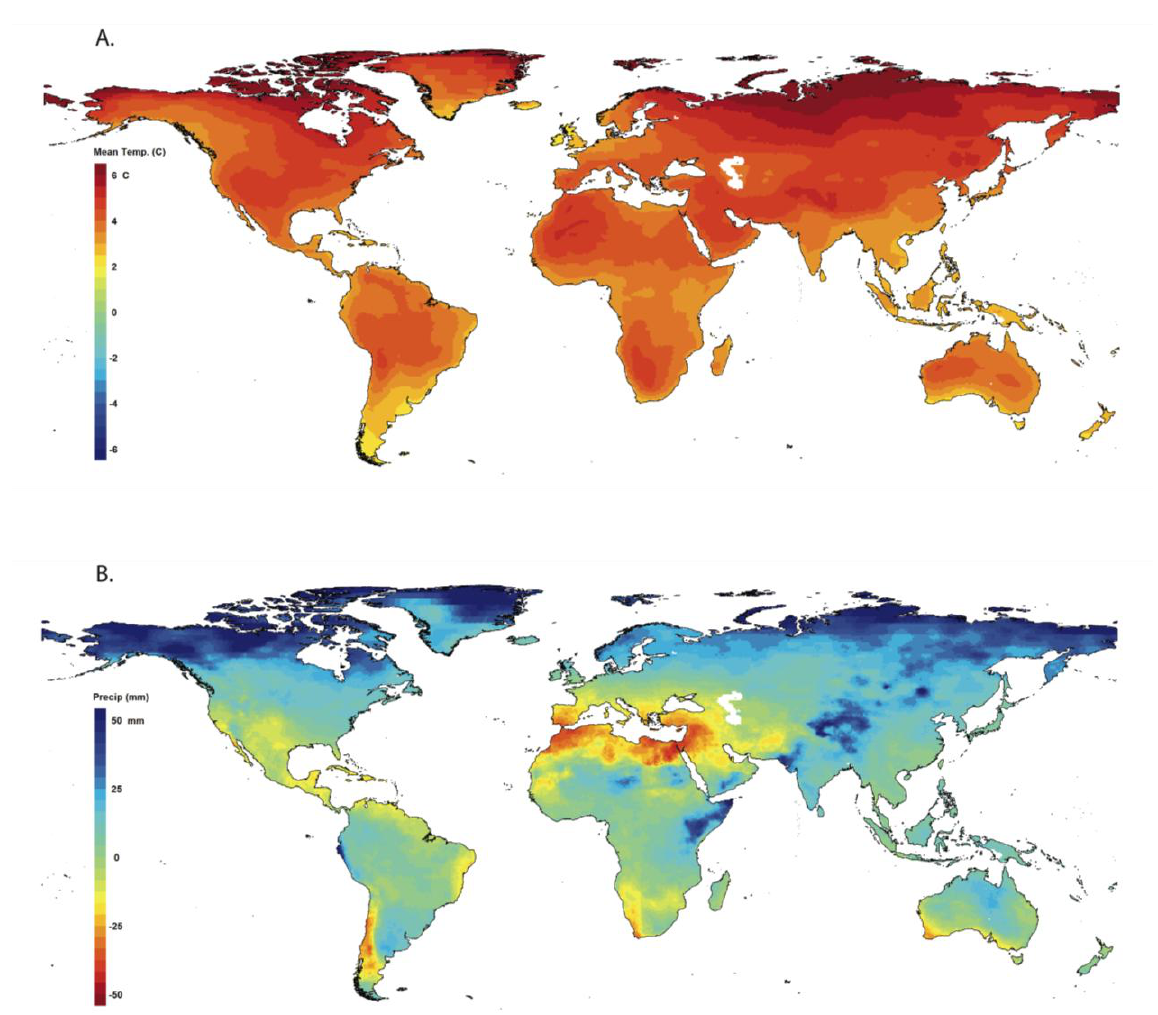
Figure 1. Projected changes in (A) mean annual temperature, and (B) total annual precipitation. All changes are for an averaged period from 2070 to 2099 relative to an averaged period from 1961 to 1990. Mapped values are the medians of projections from 16 general circulation models run for the SRES A2 emissions scenario. All 16 climate projections were created for the World Climate Research Programme’s (WCRP’s) Coupled Model Intercomparison Project phase 3 (CMIP3) multi-model dataset and used for analyses reported in the IPCC Fourth Assessment Report. The climate projections were downscaled to a 0.5-degree resolution as described in Maurer et al . [223]. The maps were created with the ClimateWizard climate data analysis tool